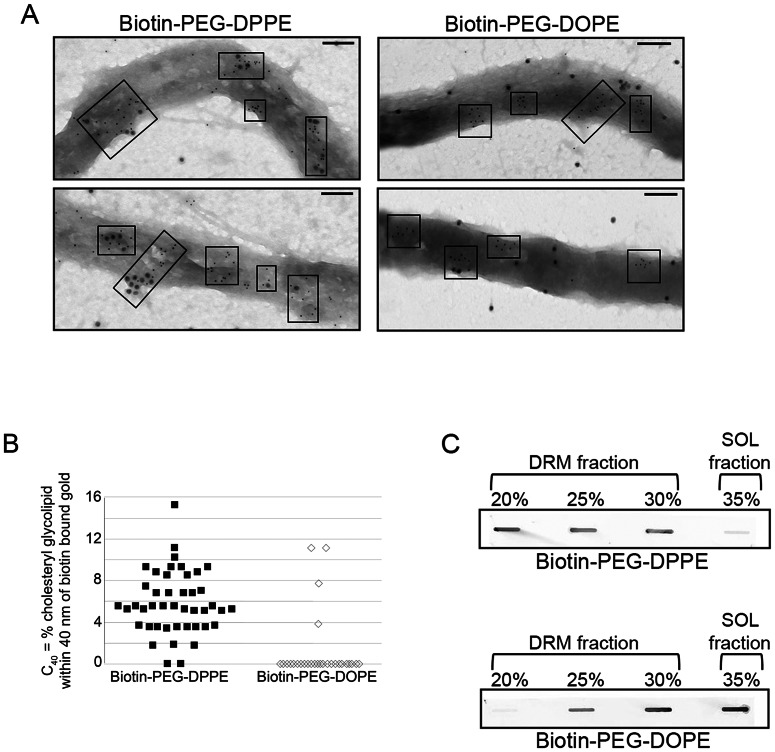
Only lipids associating with ordered domains colocalize with B.
burgdorferi sterol glycolipid domains.
A. Representative negative-stain TEM images showing localization of biotin-PEG-DPPE (left) and biotin-PEG-DOPE (right) as detected by anti-biotin and second antibody conjugated to 15 nm gold particles, in relation to cholesterol glycolipids, detected by antibody conjugated to 6 nm gold particles as in Figure 1. Electron dense areas in micrographs are sections of bacteria. Boxes denote clusters of sterol glycolipids. Notice the difference in large gold particle proximity to small gold particle clusters for biotin-PEG-DOPE and biotin-PEG-DPPE. Bars = 100 nm. B. Quantification of biotinylated lipid co-localization with cholesterol glycolipids. The co-localization parameter C40 (see Materials and Methods) indicates the percent of 6 nm gold particles within 40 nm of a 15 nm gold particle. C40 was calculated for both biotin-PEG-DOPE and biotin-PEG-DPPE samples from the mean of three different images. C. Representative immunoblots of B. burgdorferi fractions following TX-100 treatment and density gradient separation probed with anti-biotin antibodies.